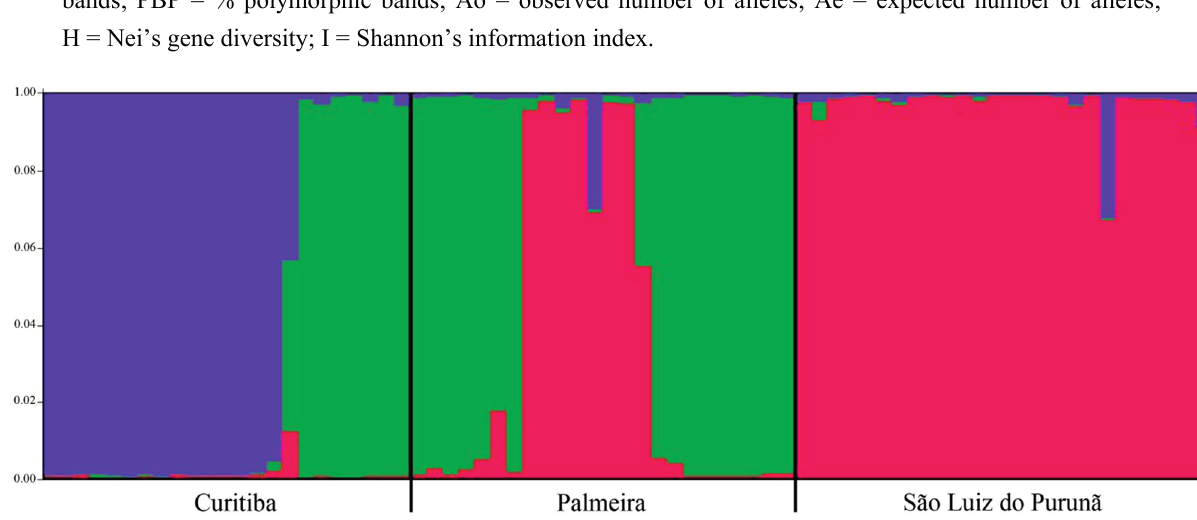
Figure 4. Estimated geographic group structure for three populations of Salvia lachnostachys Benth. with ISSR markers. Different greyscale colors indicate different geographic groups (Palmeira, São Luiz do Purunã, Curitiba). Long black lines indicate the separation among a priori assigned